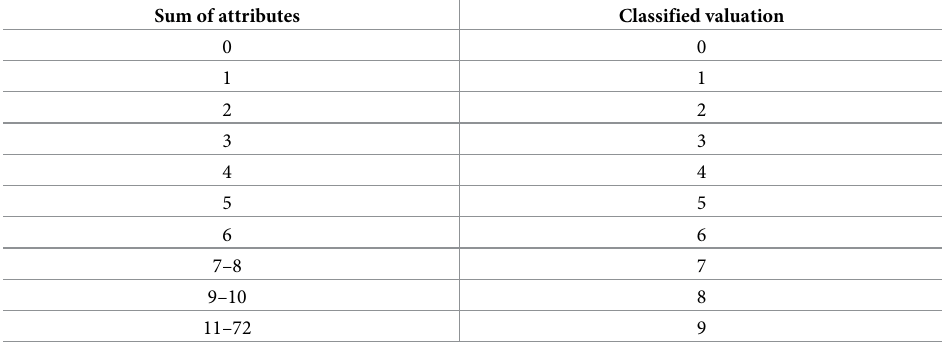
Table 4. Composite valuations for the species category based on